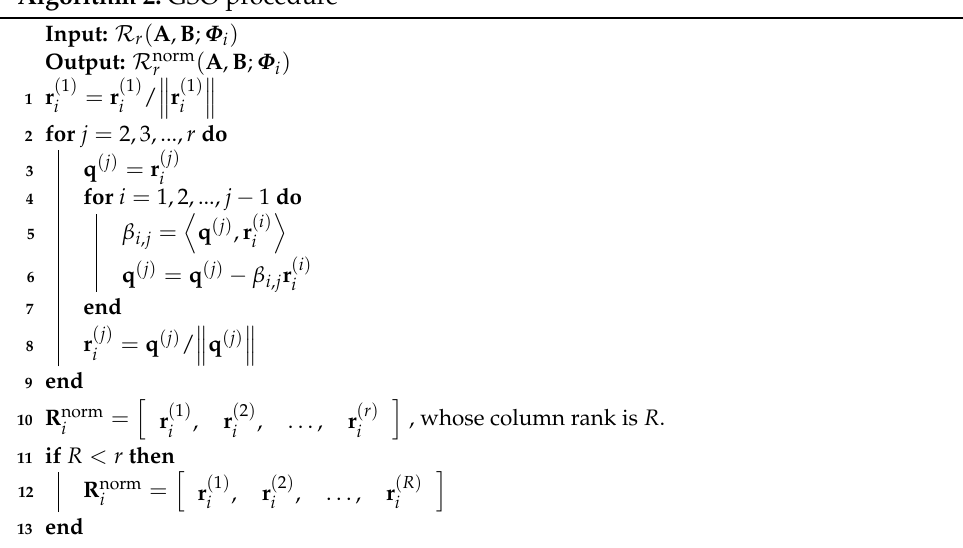
Algorithm 2: GSO procedure